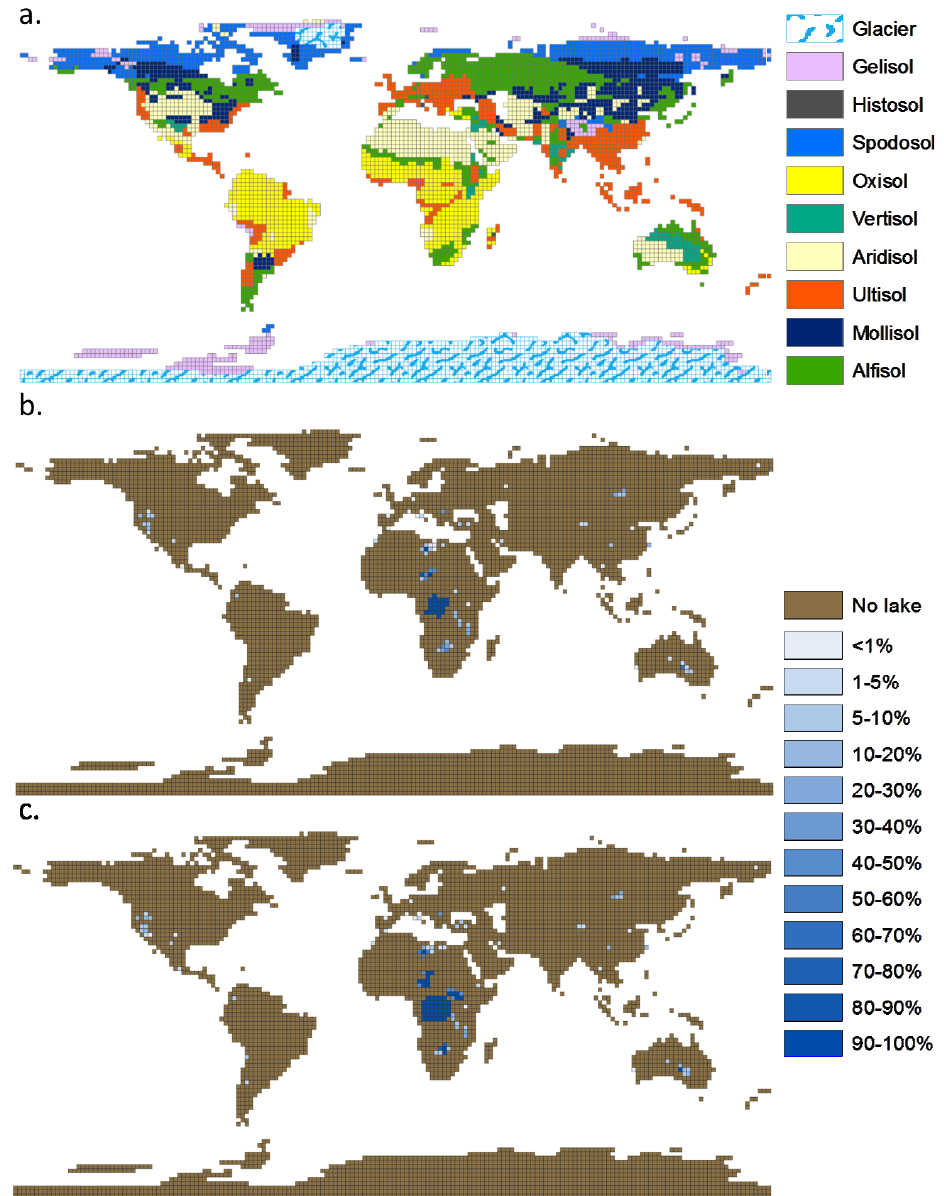
Fig. 2. The reconstructed distribution of (A) late Pliocene soils, (B) late Pliocene dry-lakes scenario and (C) late Pliocene wet-lakes Figure 2. The reconstructed distribution of A) Late Pliocene soils, B) Late Pliocene dry-lakes 829